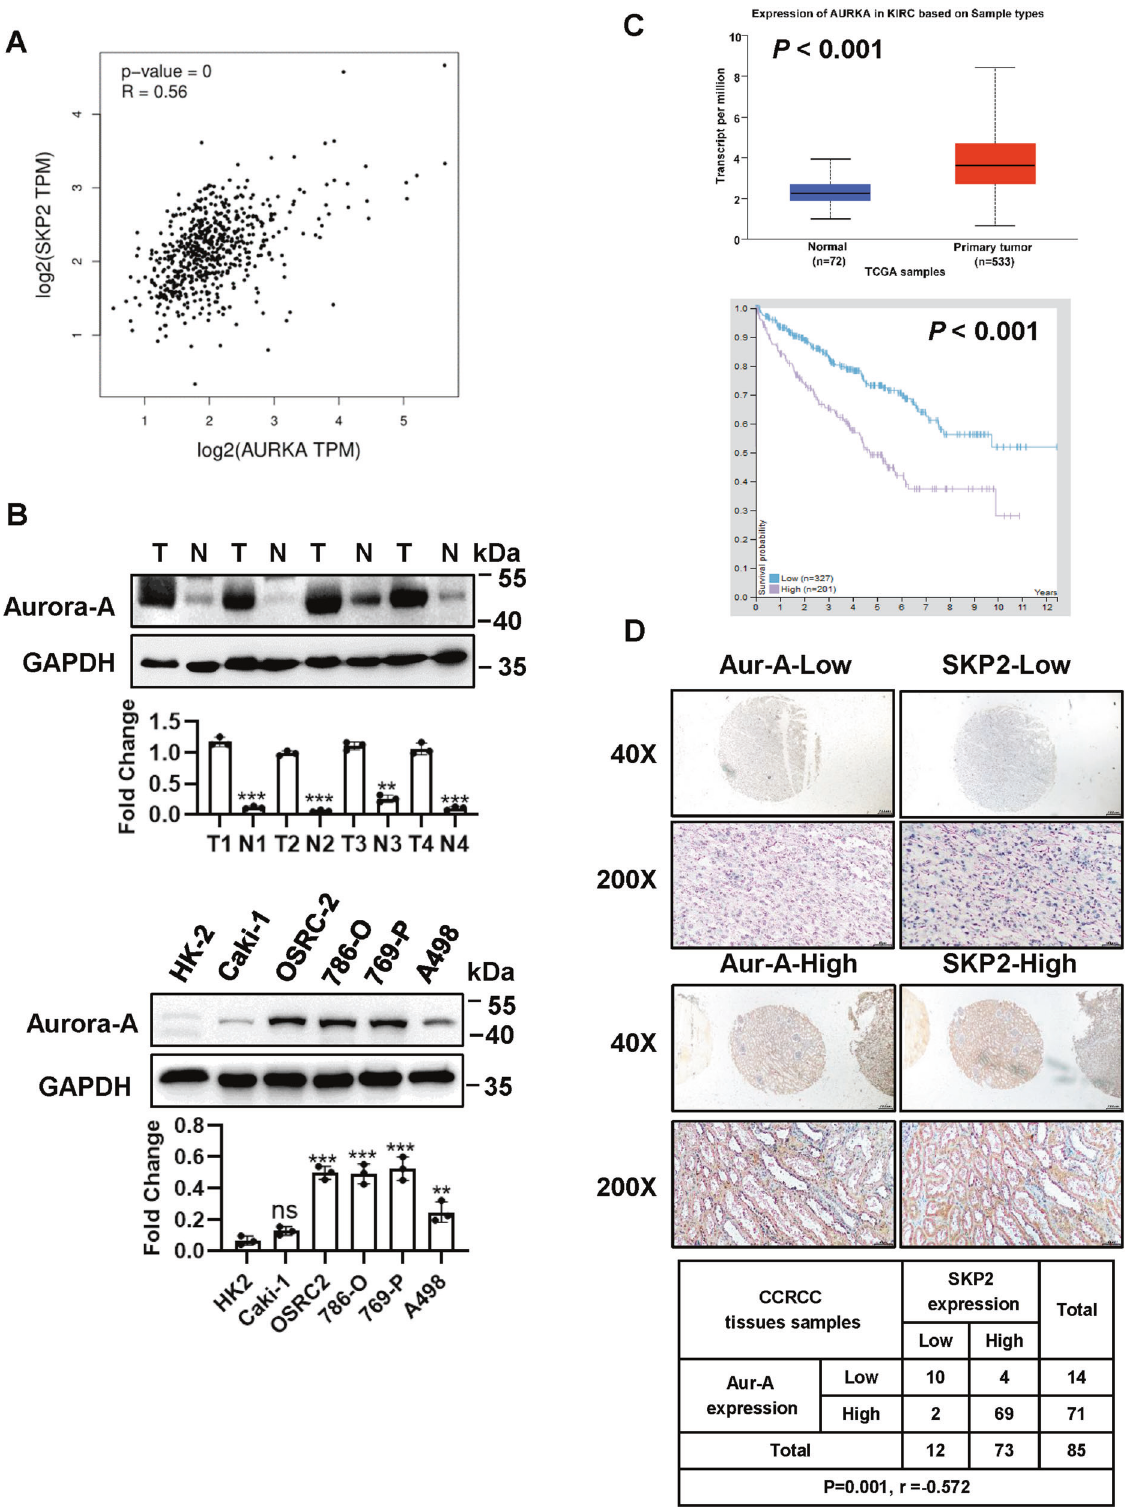
Fig. 2 SKP2 is positively correlated with Aur-A. A SKP2 was extremely correlated positive correlation with Aur-A, and data from http://gepia. cancer-pku.cn/. B Basal level of Aur-A in ccRCC tissues (T) and normal adjacent tissues (N), and ccRCC cell lines. C Expression value of Aur-A gene was higher and related to a worse overall survival in ccRCC. Bar graph showing expression values of Aur-A gene using the study dataset, and data from http://ualcan.path.uab.edu. Over survival was indicated by Kaplan – Meier survival analysis (log-rank test, p < 0.001). D SKP2 was positively correlated with Aur-A in ccRCC human tissues. ccRCC tissue microarrays were stained with Aur-A and SKP2, and then photographed (Scale bars, 200 and 50 μ m). Association analysis of Aur-A and SKP2 in ccRCC by using SPSS software. The protein levels were normalized to GAPDH. ns no signi fi cance; ** p < 0.01, *** p < 0.001; n = 3 independent experiments; two-tailed paired Student ’ s t test or one-way ANOVA with Dunnett ’ s test. Cell Death and Disease (2022)